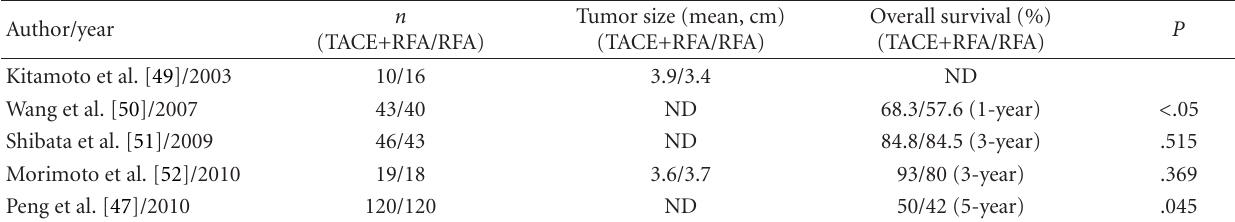
Table 3: Survivals: RFA combined with TACE versus RFA alone for HCC.